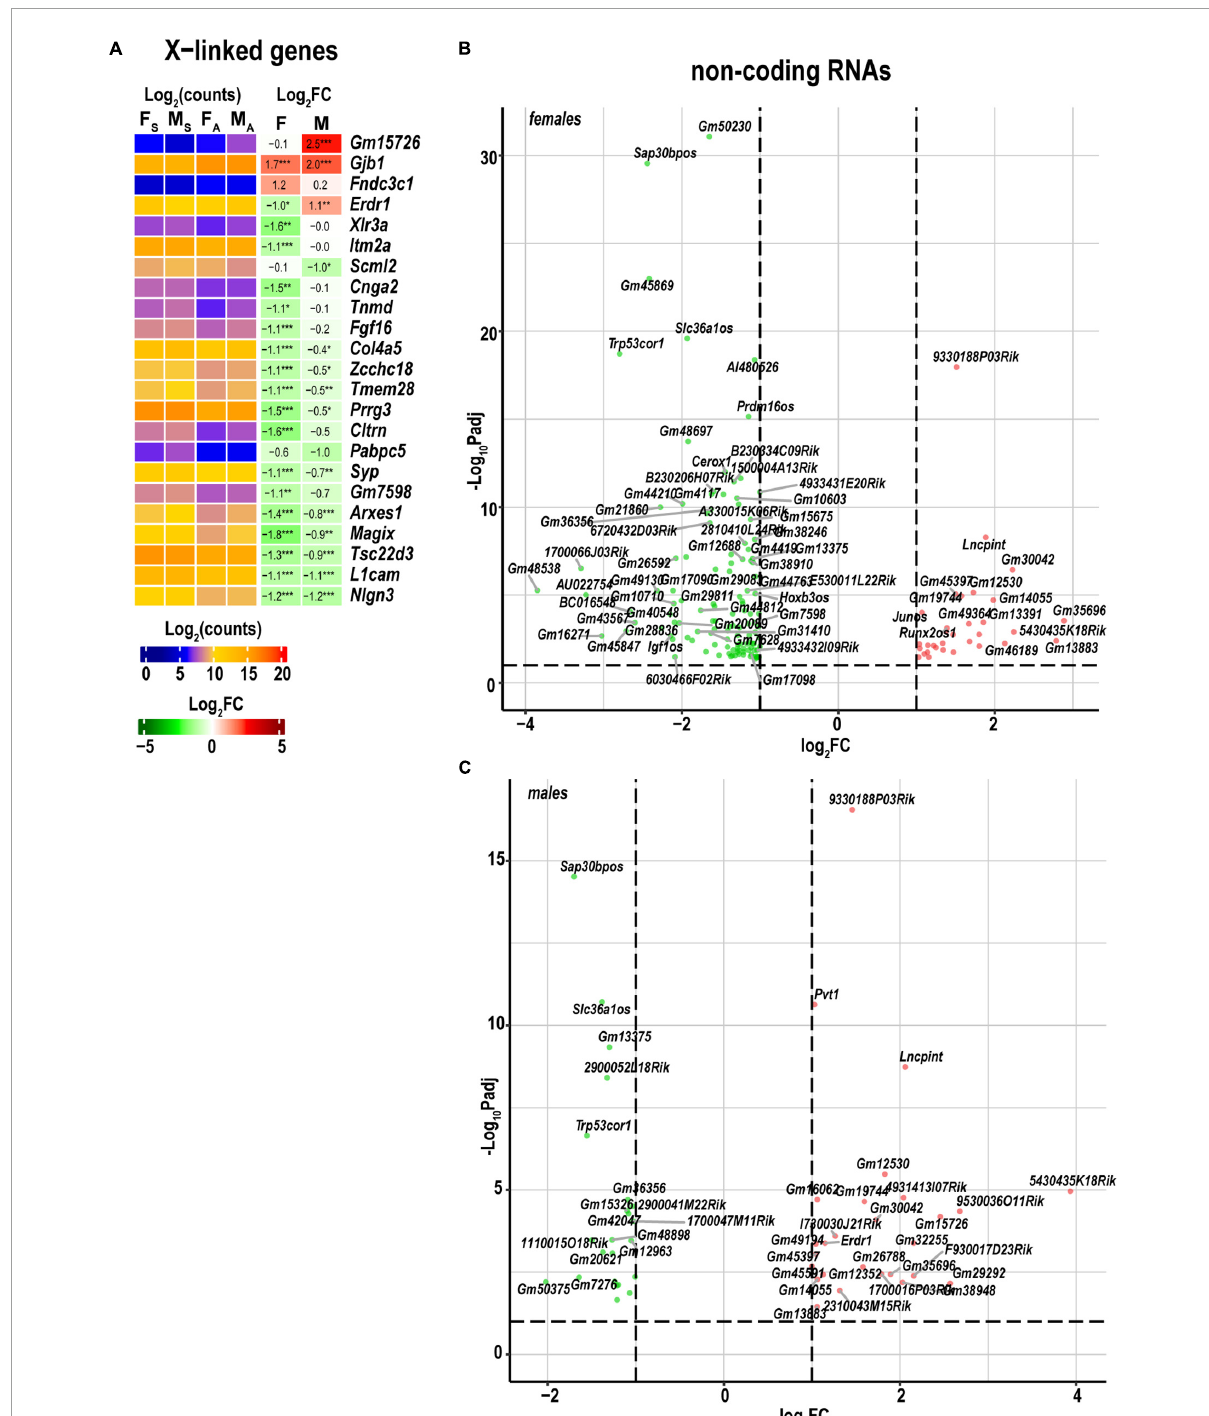
FIGURE7 Regulated X-linked and ncRNA DEGs exhibited sexual dimorphism. (A) Regulated sex chromosome-linked DEGs. Heatmaps display normalized log 2 (counts) in sample groups (F S , female sham; M S , male sham; F A , female axotomy; M A , male axotomy) and log 2 FC in female (F) and male (M); [ n = 6 mice/group, 2 mice/sample (pooled), 3 sample/group] of respective DEGs. Heatmap colors correspond to the respective scales. Log 2 FC significance was determine in DESeq2 using Wald test: * p ≤ 0.05; ** p ≤ 0.005; *** p ≤ 0.0005. DEGs were sorted by log 2 FC. Significant ncRNA DEGs in female (B) and male (C) mice. Volcano scatter plots show –log 10 P adj and log 2 FC. Red and green colors indicate up- and downregulated ncRNAs, respectively. Thresholds (log 2 FC > 1 or log 2 FC < –1) and –log 10 P adj < 0.1 are shown by dotted lines. Selected DEGs are labeled by gene